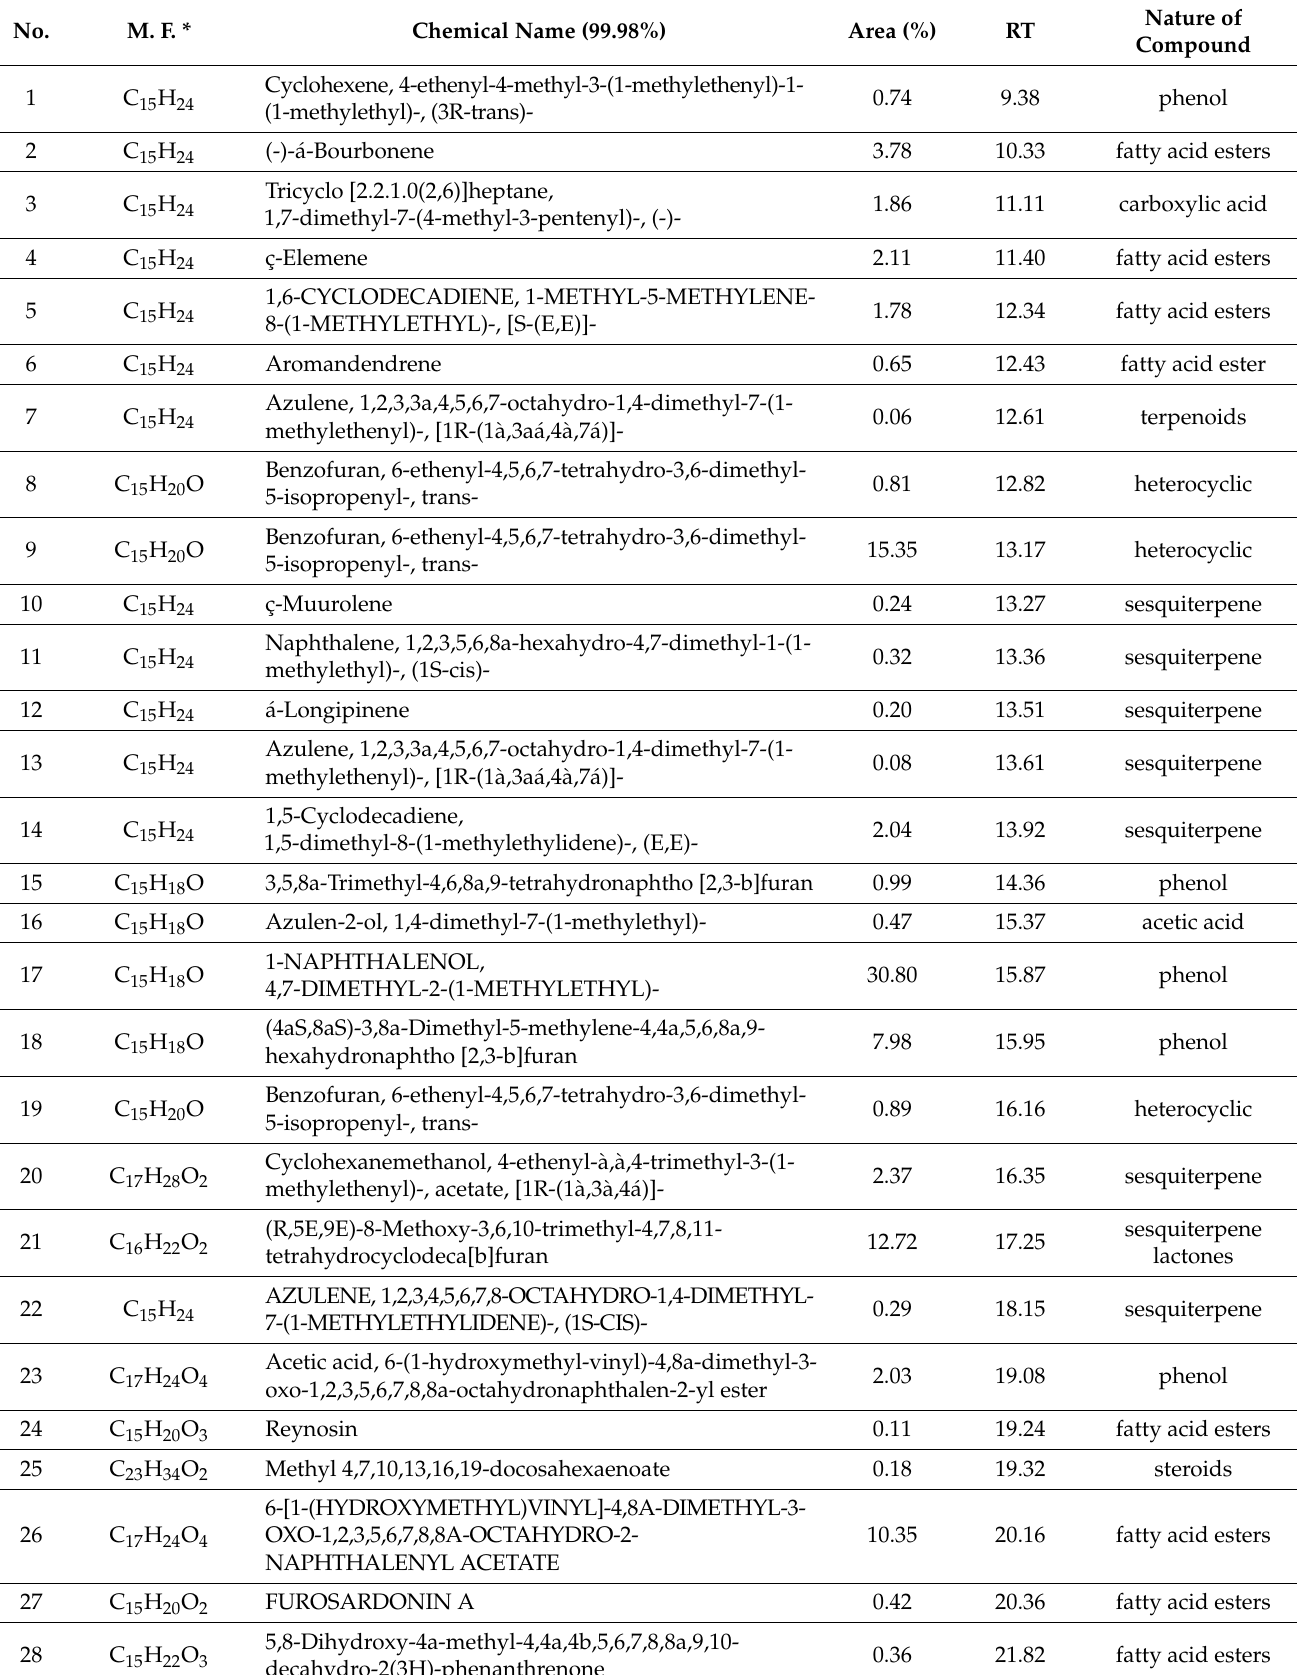
Table 9. The major chemical constituents of Commiphora molmol methanol